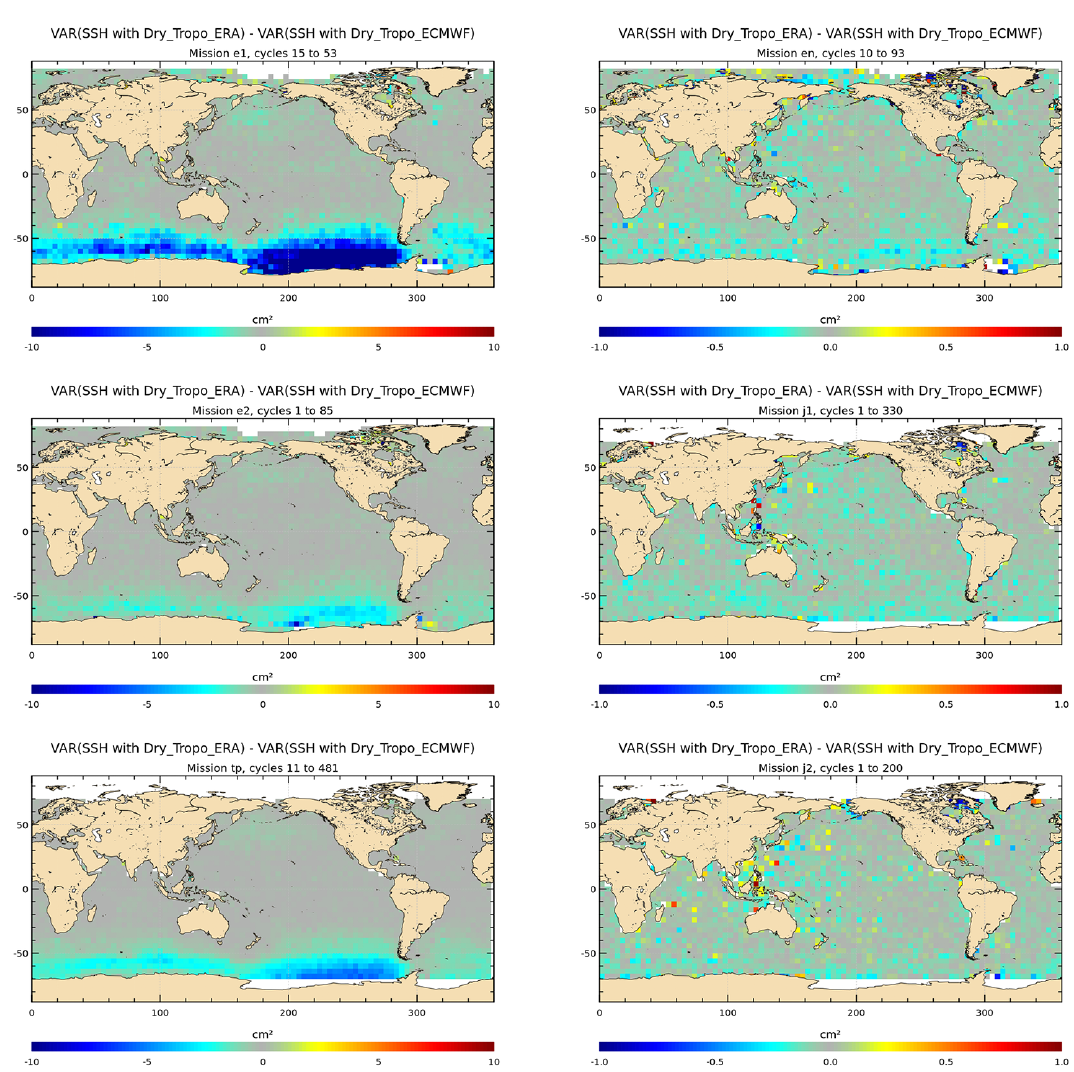
Figure 11. Maps of SSH variance differences at crossovers successively using the ERA-Interim and ECMWF operational DT corrections in the SSH calculation for ERS-1, ERS-2, and TOPEX (on the left), and for Envisat, Jason-1, and Jason-2 (on the right) (cm 2